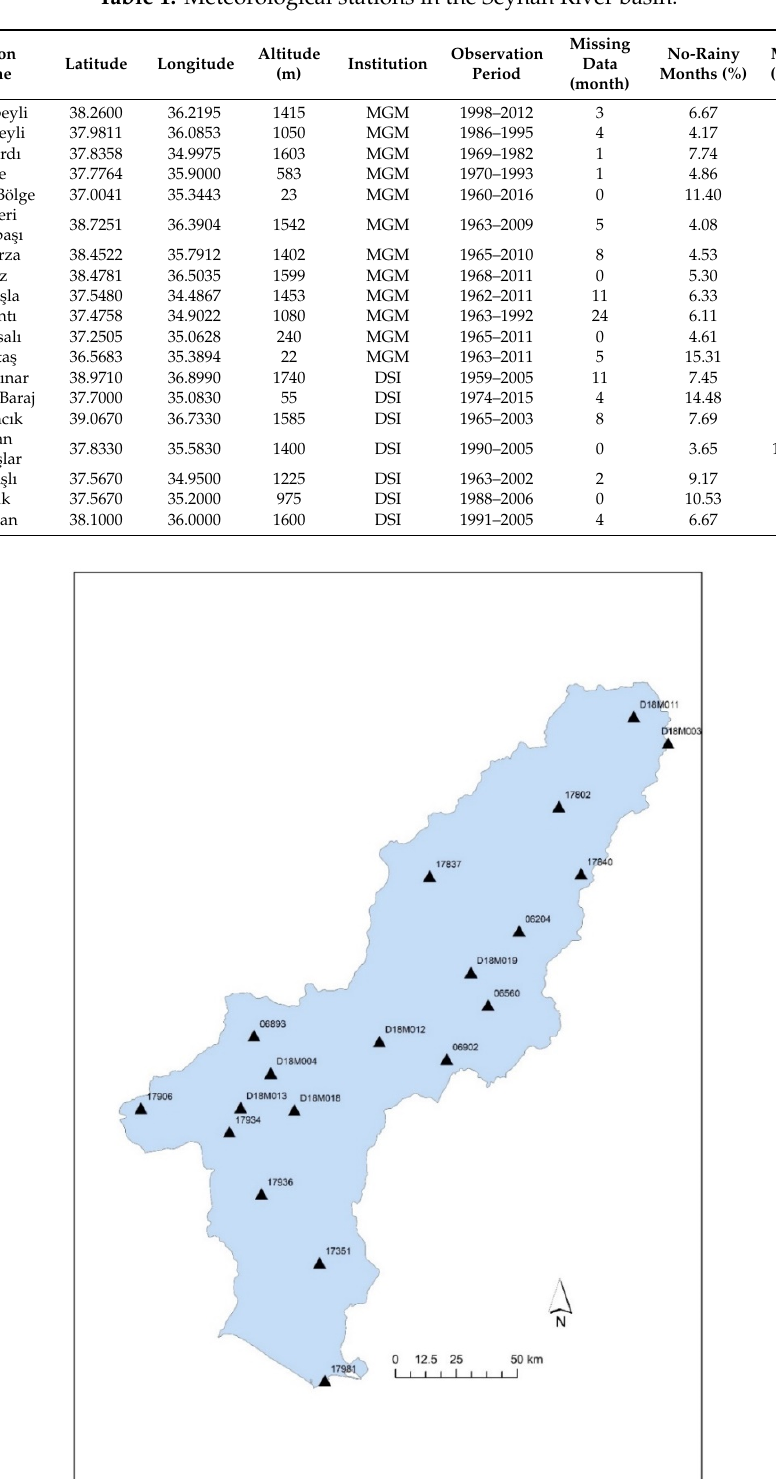
Figure 2. Layout of the meteorological stations in the Seyhan River basin.